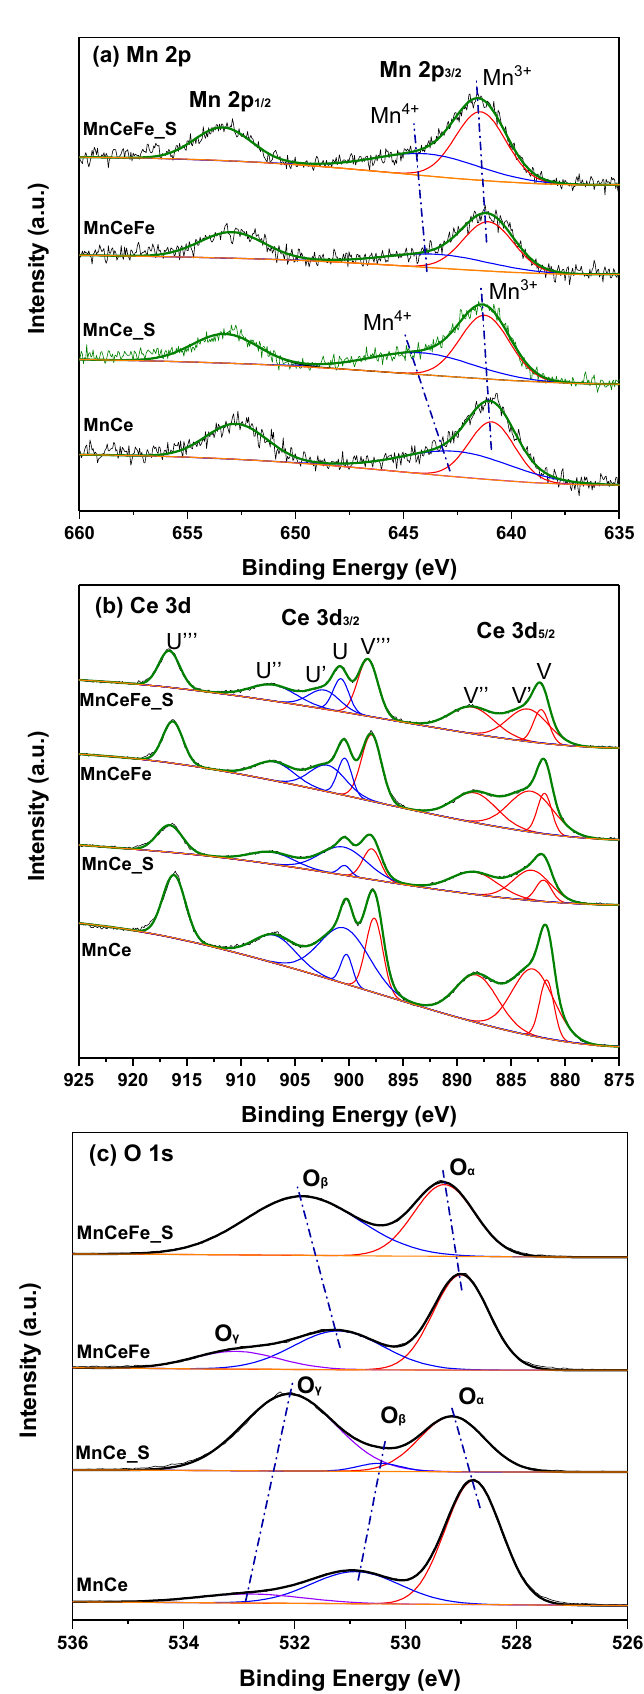
Figure 3. XP spectra of MnCe, MnCe_S, MnCeFe, and MnCeFe_S, ( a ) Mn 2p, ( b ) Ce 3d, ( c ) O